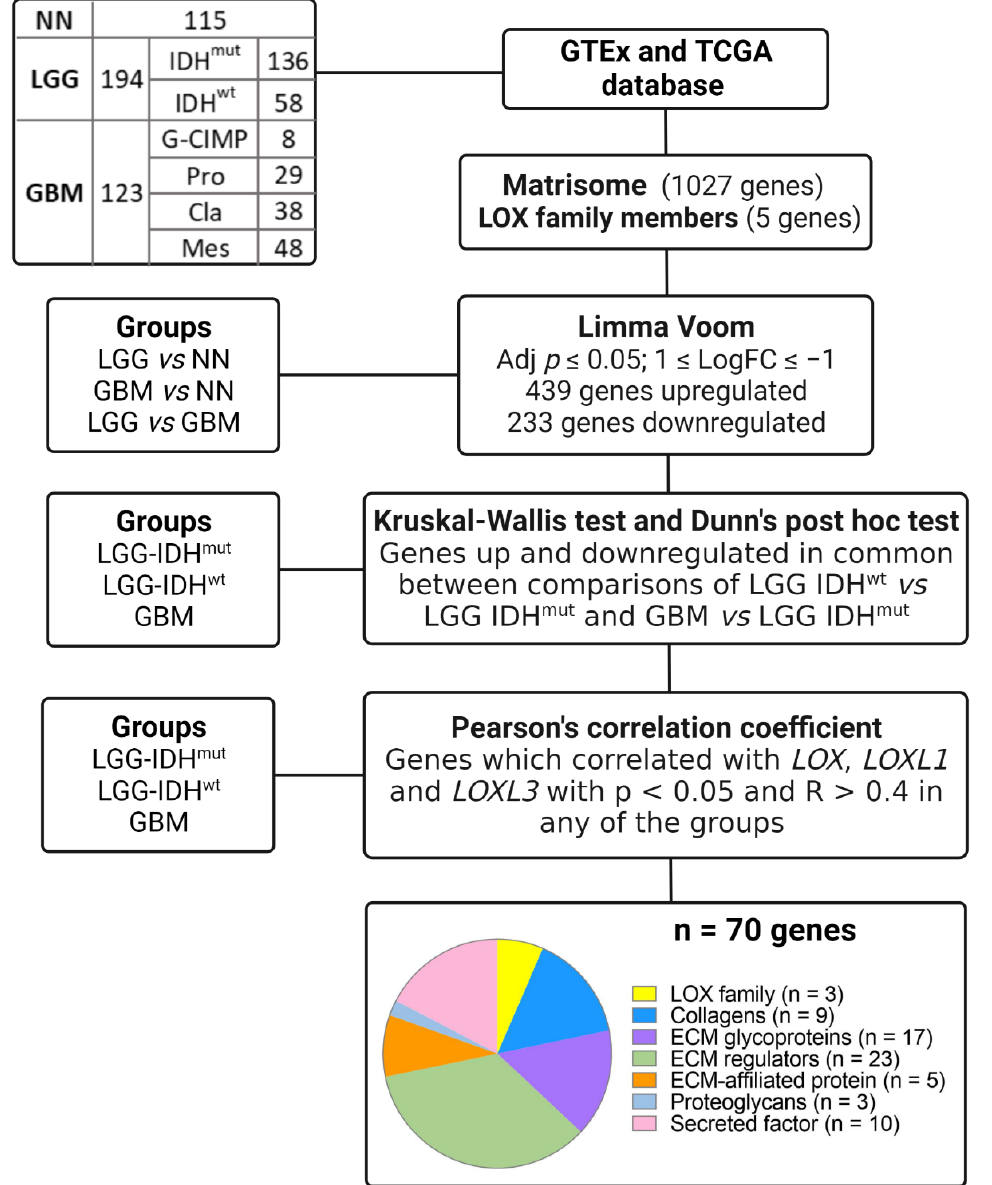
Figure 4. Workflow of in silico analysis of genes coding for matrisome and LOX family in LGG and GBM cohort on TCGA database. Abbreviations: ECM, extracellular matrix; FC, fold change; GBM, glioblastoma; GTEx, Genotype-Tissue Expression; IDH mut , isocitrate dehydrogenase gene with mutation; IDH wt , isocitrate dehydrogenase gene wild type; LGG, lower-grade astrocytic glioma; NN, non-neoplastic; TCGA, The Cancer Genome Atlas. Created with BioRender.com.